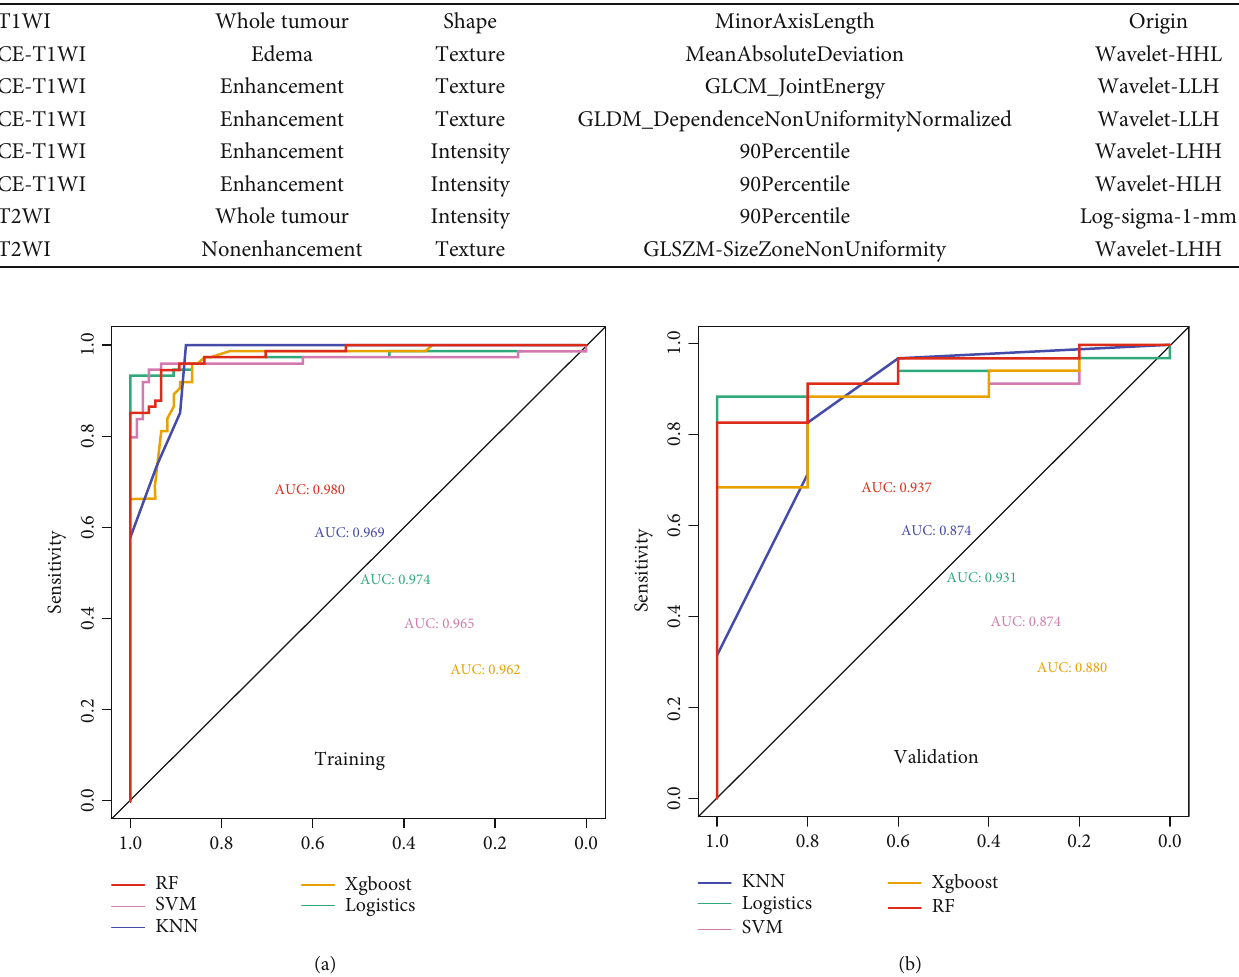
Figure 4: Receiver operating characteristic (ROC) curves of training (a) and validation (b) sets under di ff erent machine learning algorithms. It can be seen from the fi gure that the random forest algorithm performs best. KNN: k -nearest neighbour; logistics: logistic regression; SVM: support vector machine; Xgboost: extreme gradient boosting; RF: random forest. Table 3: A summary of the AUC with di ff erent machine learning methods on the TCIA dataset.